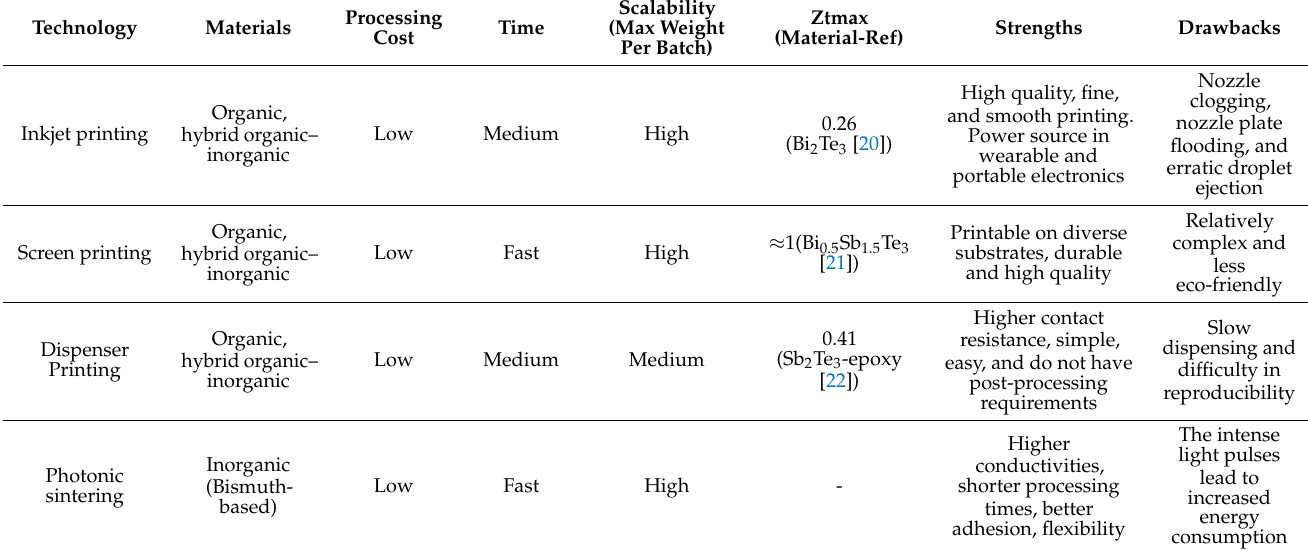
Table 2. Summary of recent progress in prominent large-scale fabrication